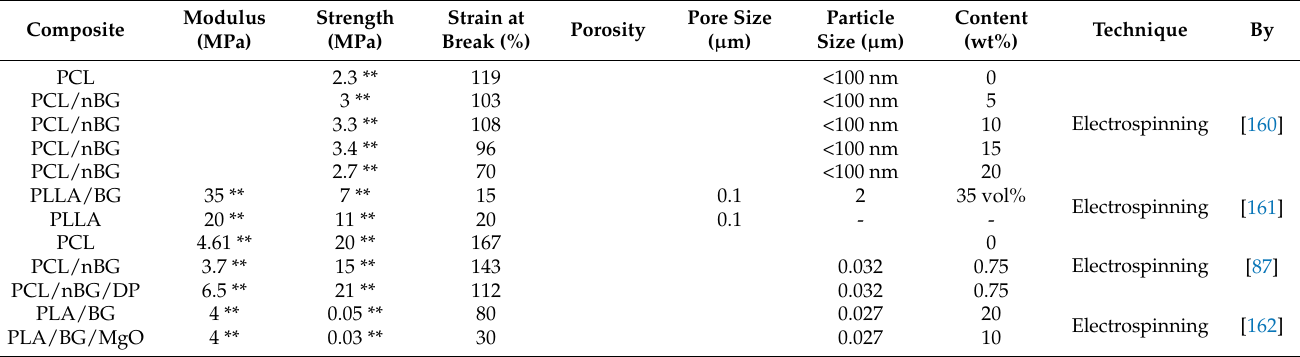
Table 6 . Principal properties of electrospinning investigations. With * the compression, ** tensile 656 and *** flexural modulus/strength (not filled cells mean no data).